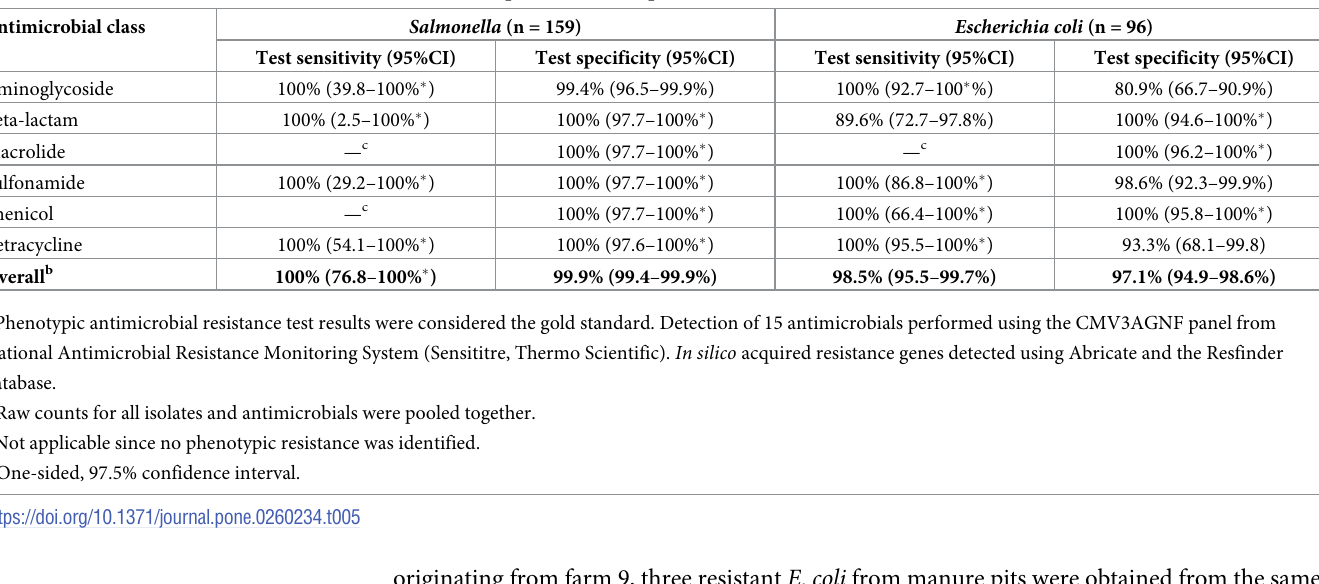
Table 5. Test sensitivity and specificity a for in silico identification of acquired antimicrobial resistance genes in Salmonella enterica and phenotypically resistant Escherichia coli isolates obtained from raccoons, swine manure pits, and soil samples on swine farms in southern Ontario, Canada